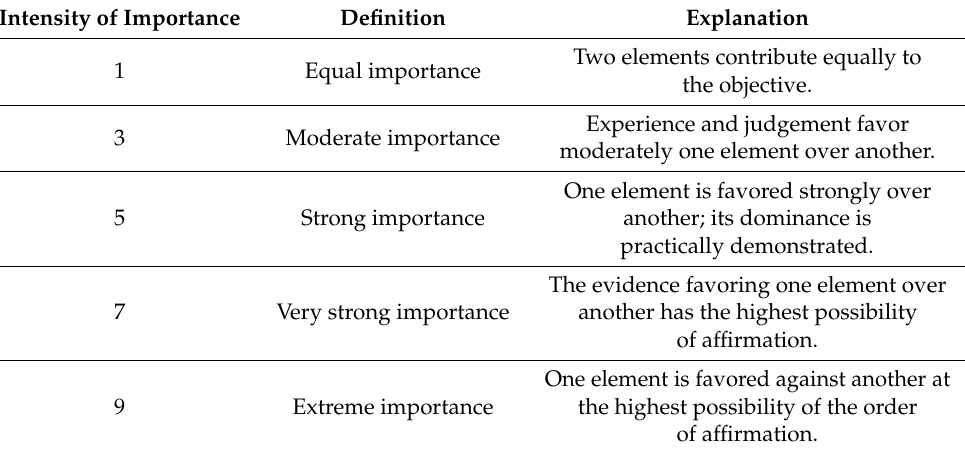
Table 3. The fundamental scale for pairwise comparisons.